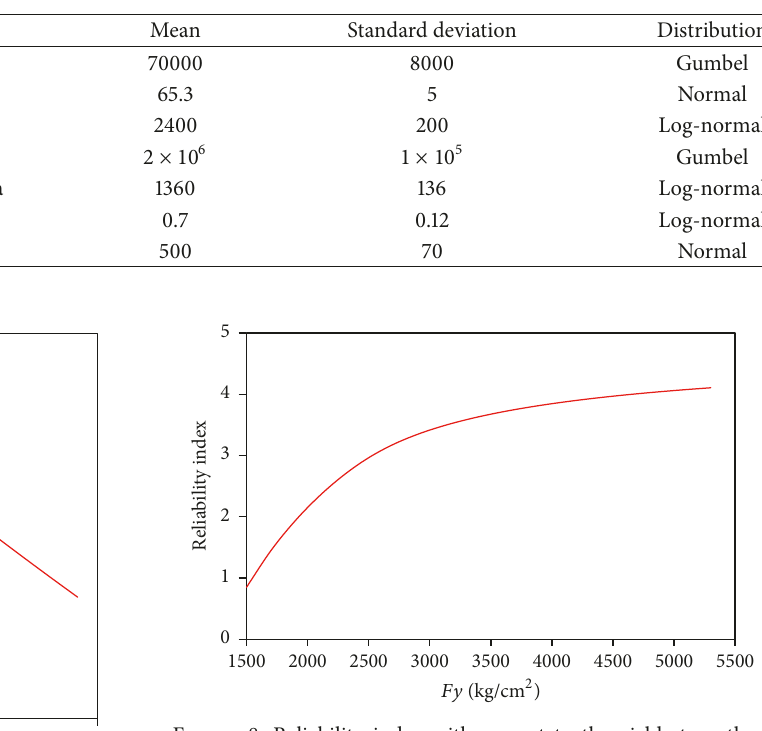
Table 2: Statistical characteristics of random variables for the example of column.